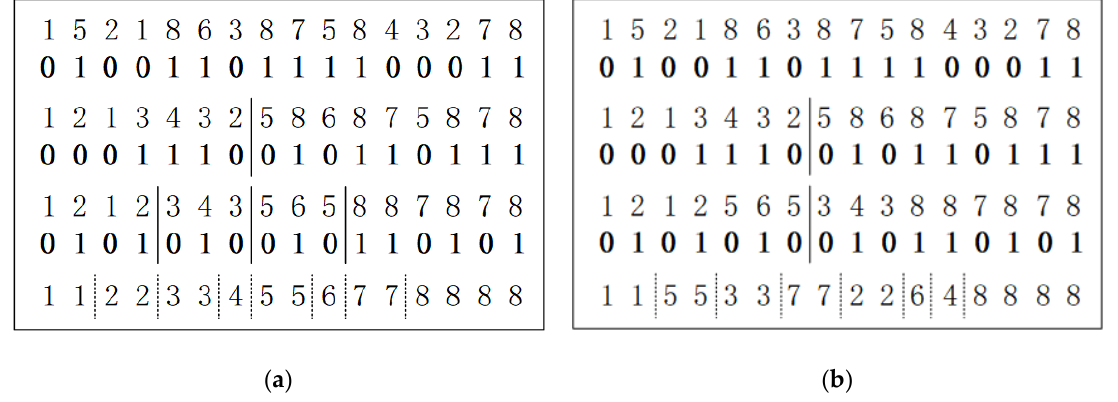
Figure 2. ( a ) The wavelet tree without pointers for sequence S = { 1521863875843278 } ; ( b ) the wavelet matrix for the same sequence S = { 1521863875843278 } .